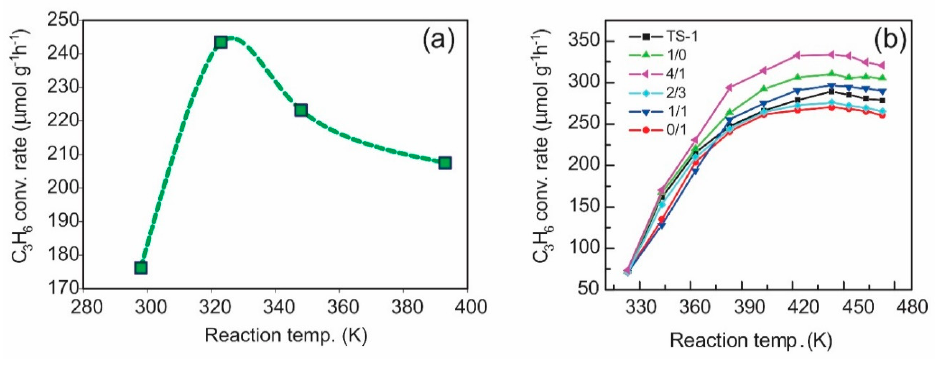
Figure 7. The influence of reaction temperature on the conversion rate of propylene: ( a ) V-Ti/MCM- 41 [15] and ( b ) Au-Ag/TS-1 photocatalysts. Reproduced with permission from [42] .